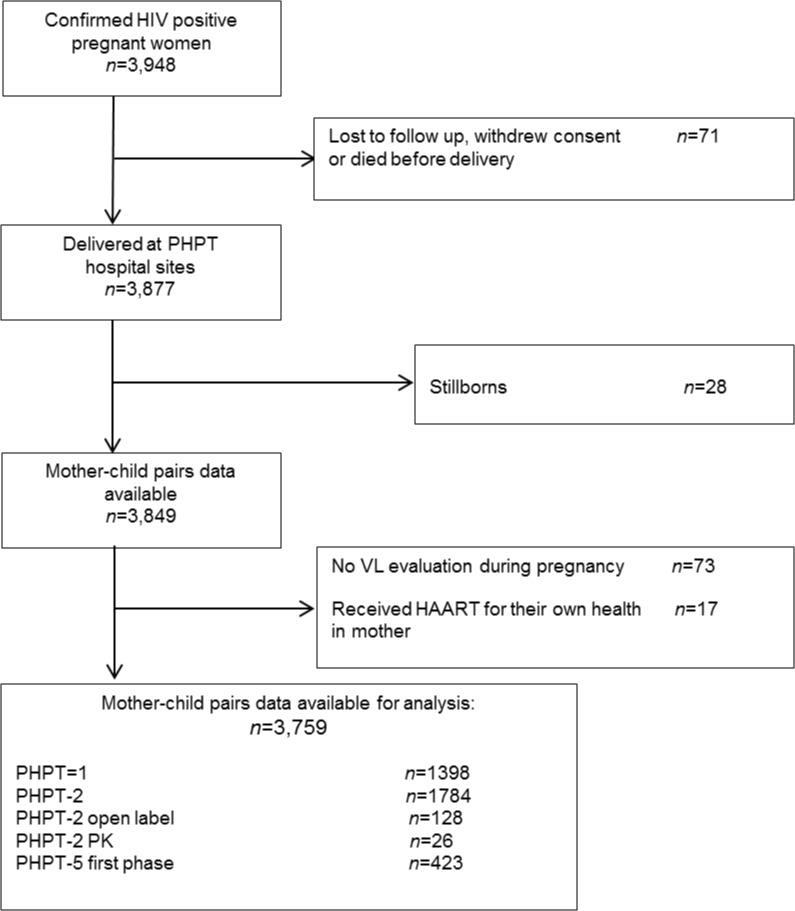
Population disposition.